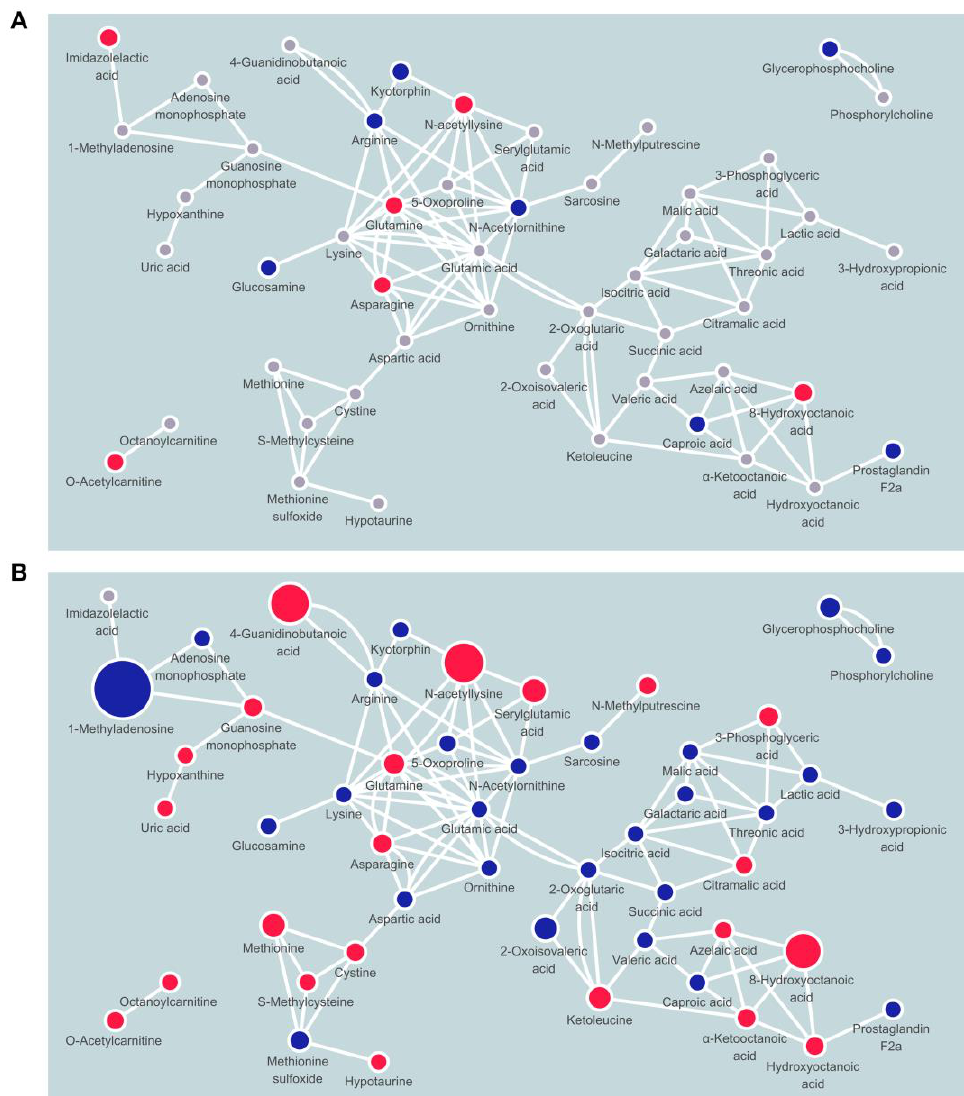
Figure 3. Network mapping showing significantly changed metabolic pathways by weight-loss in- tervention after ( A ) 6 months and ( B ) 18 months. Node color indicates direction of changes (red, up; blue, down) or non-significance (gray).